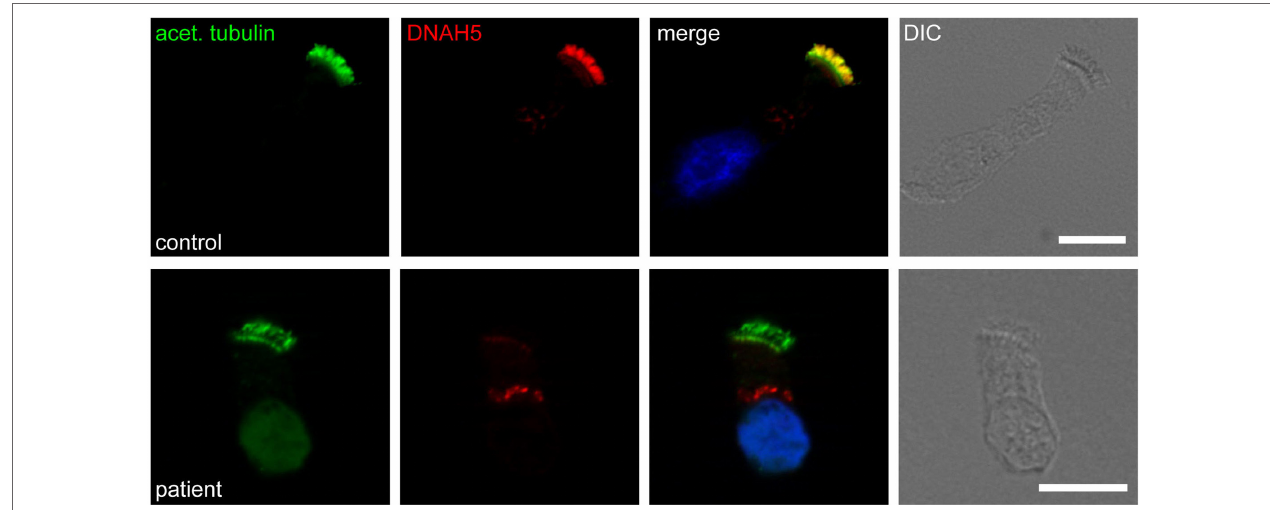
FiGURe 4 | Immunofluorescence staining of human respiratory epithelial cells with DNAH5-specific antibodies (red) and antibodies against acetylated α -tubulin (green). Nuclei were stained with Hoechst 33342 (blue). Overlays and bright-field images are shown on the right. Whereas in healthy human respiratory epithelial cells (control; upper panel), both antibodies colocalize along the entire length of the ciliary axonemes, in an individual with an outer dynein arm defect (patient; lower panel), DNAH5 is